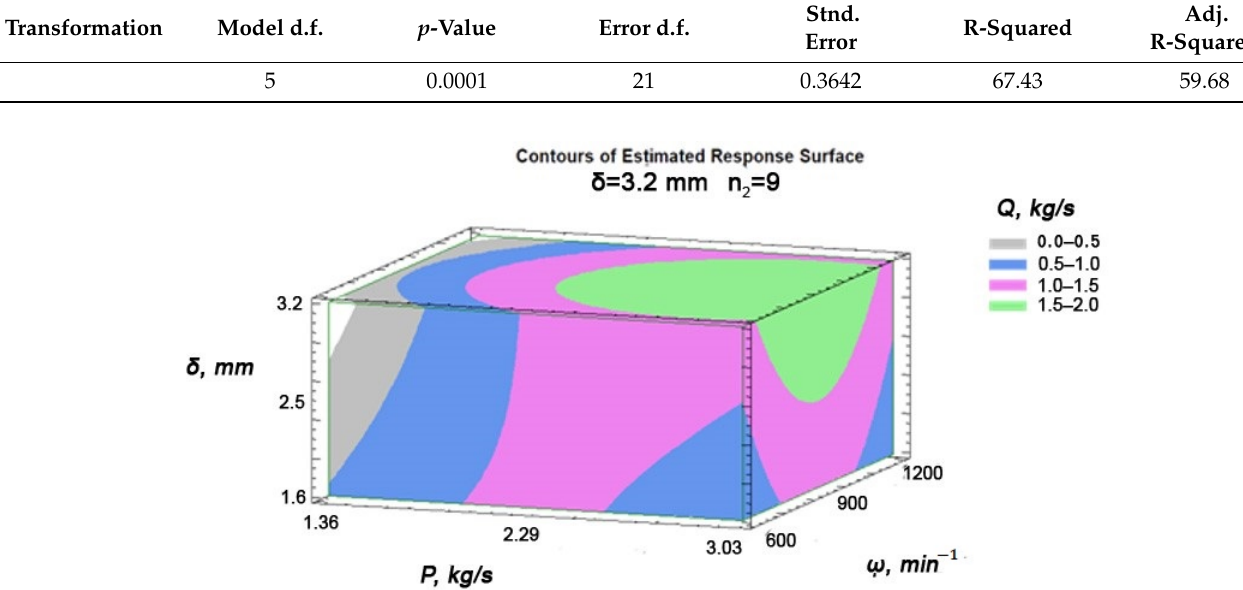
(22) The relative error of the calculated data from the experimental data varied from 10 (cid:2879)(cid:2877) to 10 (cid:2879)(cid:2873) %, except for the second row in Table 2, where the error was 45%. This is due to the measurement error in obtaining experimental data and is confirmed by the data of dispersion analysis—see Table 1. The article describes the device and the principle of operation of forage grain crush- ers that use the centrifugal force of inertia to supply the working bodies, which is formed as a result of the rotation of the rotor with a vertical axis. The drawback of most research projects is that there are no reasons to create shredders of this class with a wide range of performance [25]. An example of a construction is given and the principle of operation of a grinding machine with a centrifugal impeller is described. Based on the analysis of the presented construction of the grinder, mathematical modeling was carried out in order to obtain the dependence of the impact of constructional and technological parameters on productivity. Dimensionless coefficients of the derived empirical regularity have been es- tablished experimentally. 4. Conclusions (1) The use of similarity theory and dimension analysis allowed us to obtain an empirical dependence for calculating the performance of a centrifugal-rotary grain shredder of the considered design. Thus, this method makes it possible to solve the problem of establishing the relationship between different parameters with a minimum amount of experimental work with sufficient confidence. Therefore, at the next stage of our